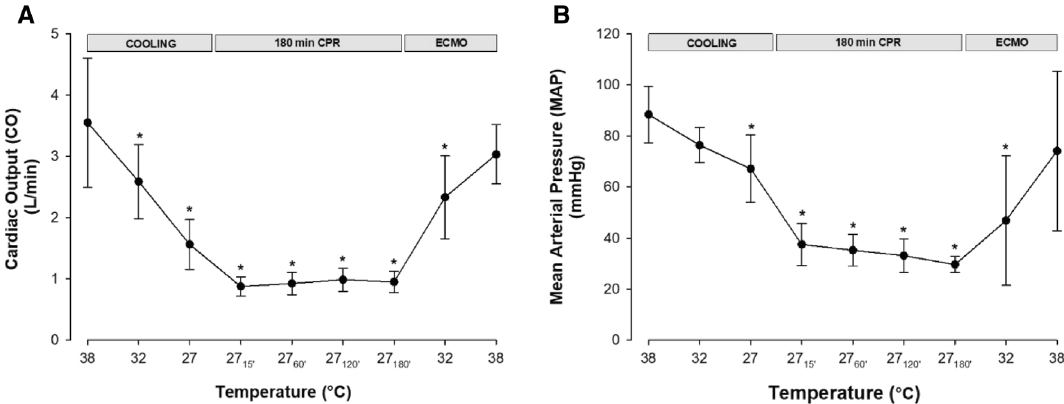
Figure 1. Measurements of hemodynamic function during cooling, 3-h CPR at 27 °C, and ECMO rewarming. ( A ) Cardiac output. ( B ) Mean arterial pressure. n = 8, values are mean ± SD. * p < 0.05 statistically significantly different from baseline